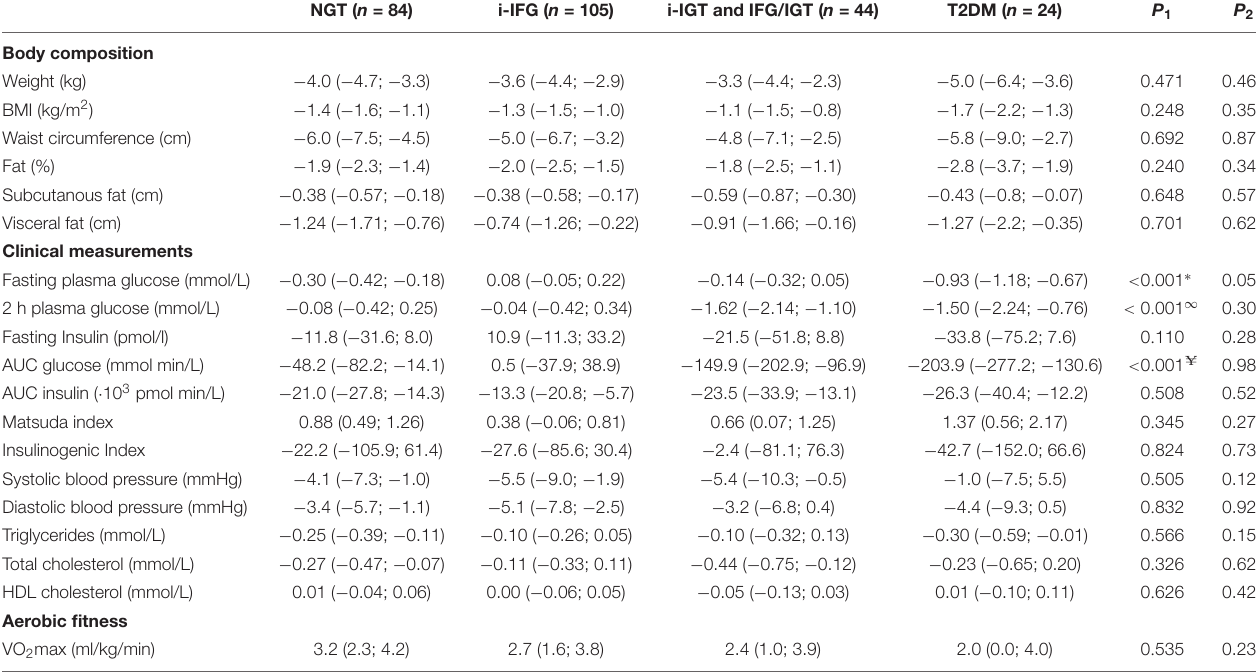
TABLE 2 | Estimated impact of the intervention (imputed data) by glycemic